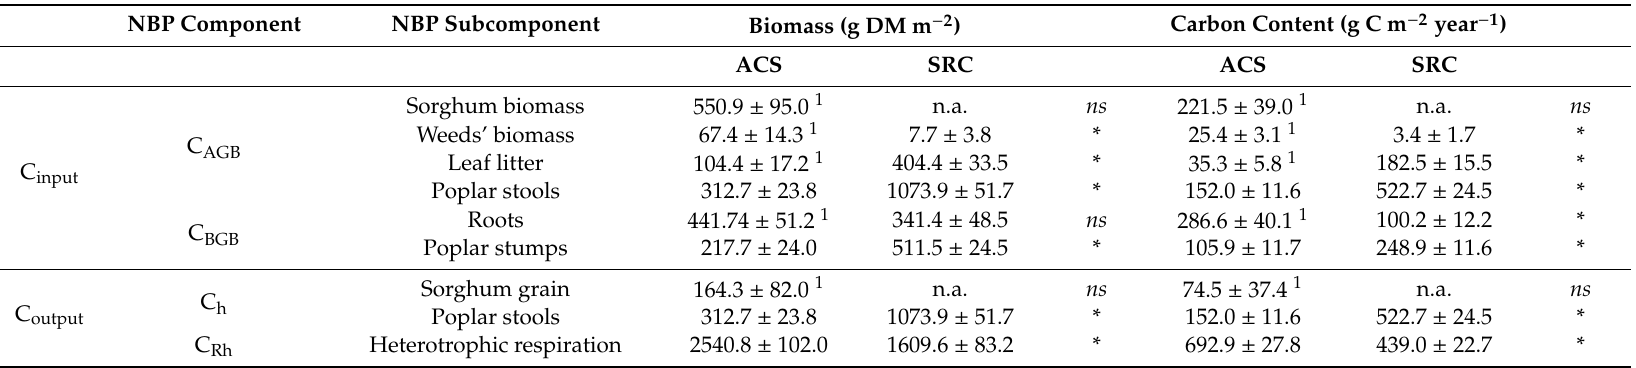
Table 4. NBP subcomponent values: biomass per surface unit (g DM m − 2 year − 1 , average ± SE) and C content (g C m − 2 year − 1 ) in the two systems (ACS: Alley Cropping System; SRC: Short Rotation Coppice system; AGB: Aboveground biomass; BGB: Belowground biomass; Rh: Heterotrophic respiration). Asterisks represent significative di ff erences in the biomass and C content between the investigated systems ( ns : not significative; *: p <